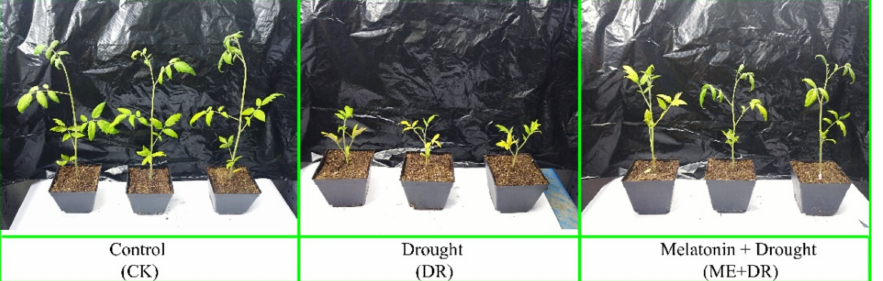
Figure 1. Tomato seedlings visual demonstration under ME and DR stress. Photographs of the tomato seedlings were taken.